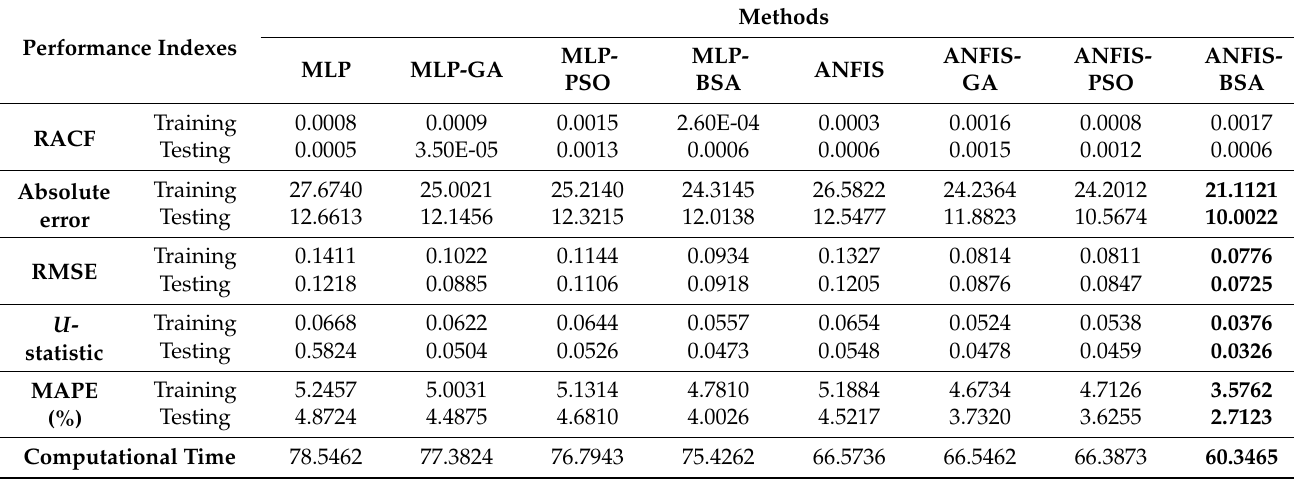
Table 8. Comparison performance indexes of multiple metaheuristic techniques corresponding to the forecasting accuracy for EPF in November 2018 in QLD.